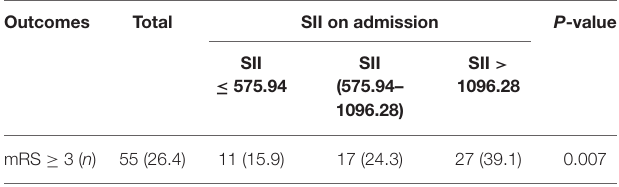
TABLE 2 | Comparison of outcomes among the three subgroups on the basis of SII.